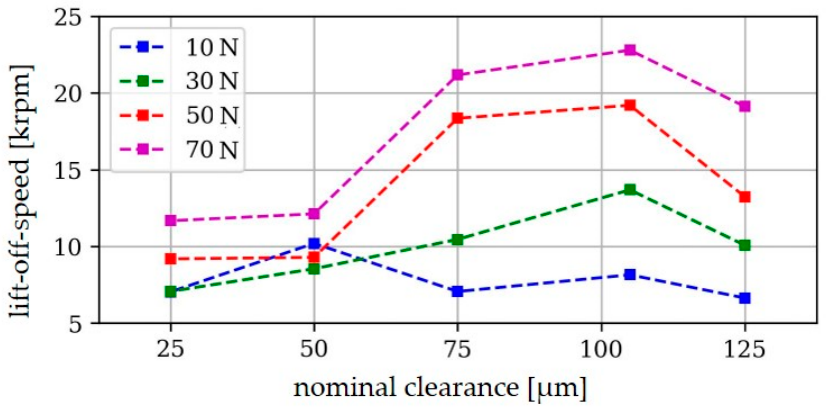
Figure 8. Illustration of the determined lift-off speeds (krpm) for each bearing configuration and the corresponding nominal clearance (µm) depending on the applied static load (N); (blue: 10 N), (green: 30 N), (red: 50 N), and (purple: 70 N); (1 krpm = (100/3)π ⋅ rad/s).